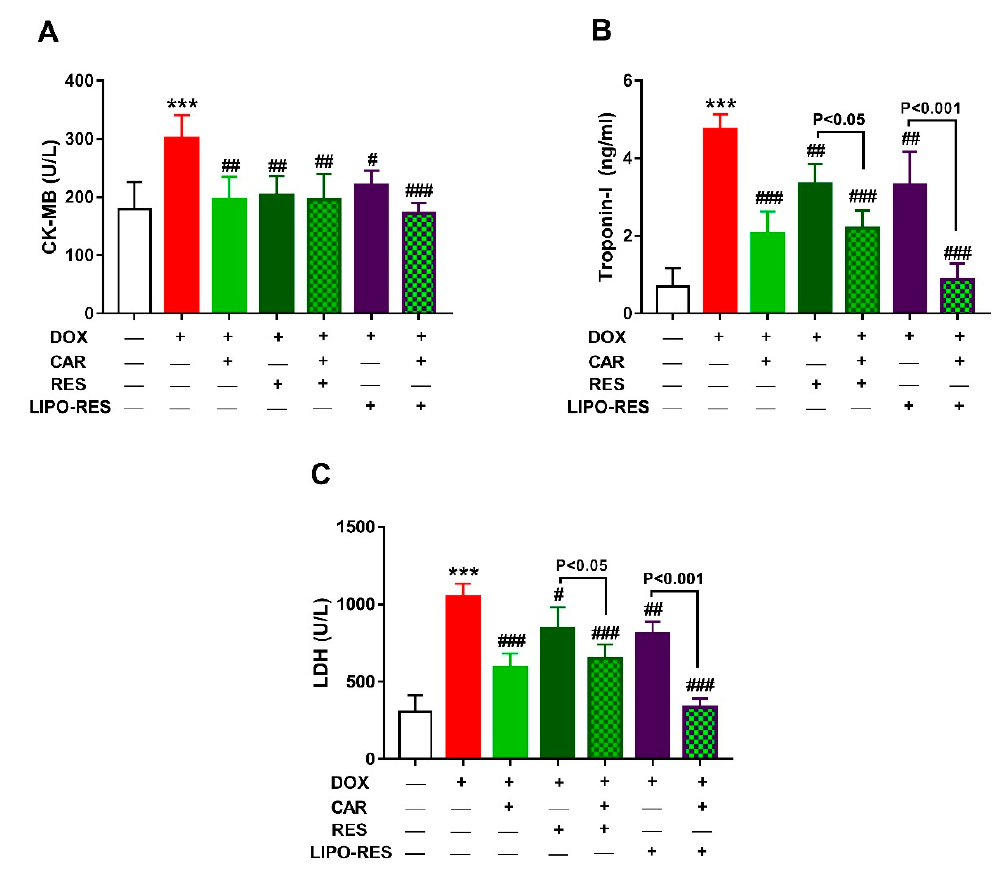
Figure 1. Carvedilol (CAR) and / or resveratrol (RES) and LIPO-RES ameliorate serum CK-MB ( A ), troponin-I ( B ) and LDH ( C ) in DOX-intoxicated rats. Data are expressed as mean ± SEM, ( n = 6). *** p < 0.001 versus Control. # p < 0.05, ## p < 0.01 and ### p < 0.001 versus DOX.